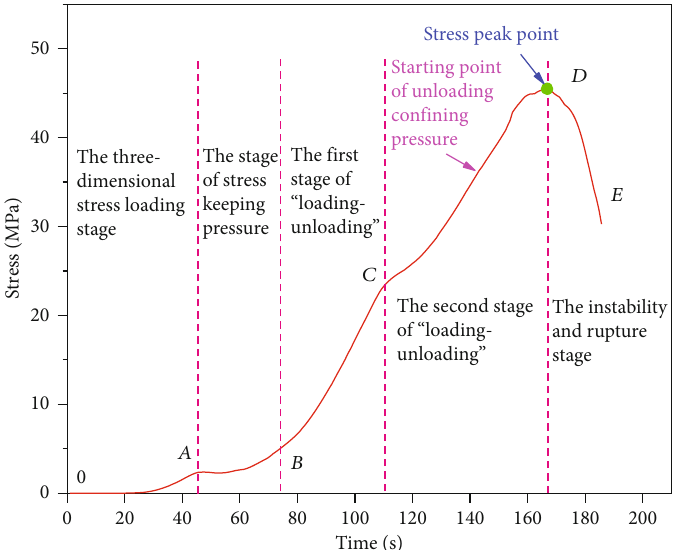
Figure 1: The stress-time curve of compound coal-rock. The con fi ning pressure is set to 10MPa, the unloading rate is 0.05 MPa/s, and D is the stress peak point. The three-axis loading and unloading of composite coal-rock is divided into fi ve